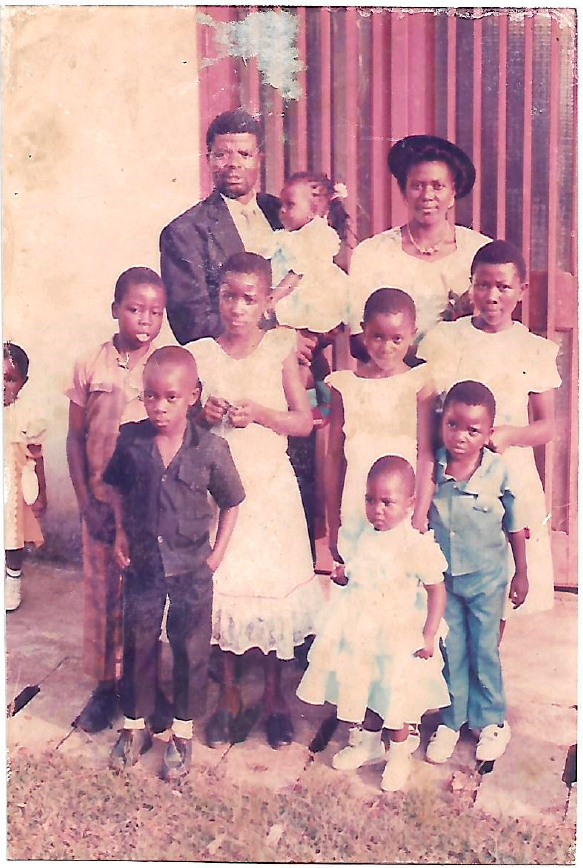
Figure 3. Mbain and his family in Buea, with his children well-dressed and his wife wearing a beaver hat.